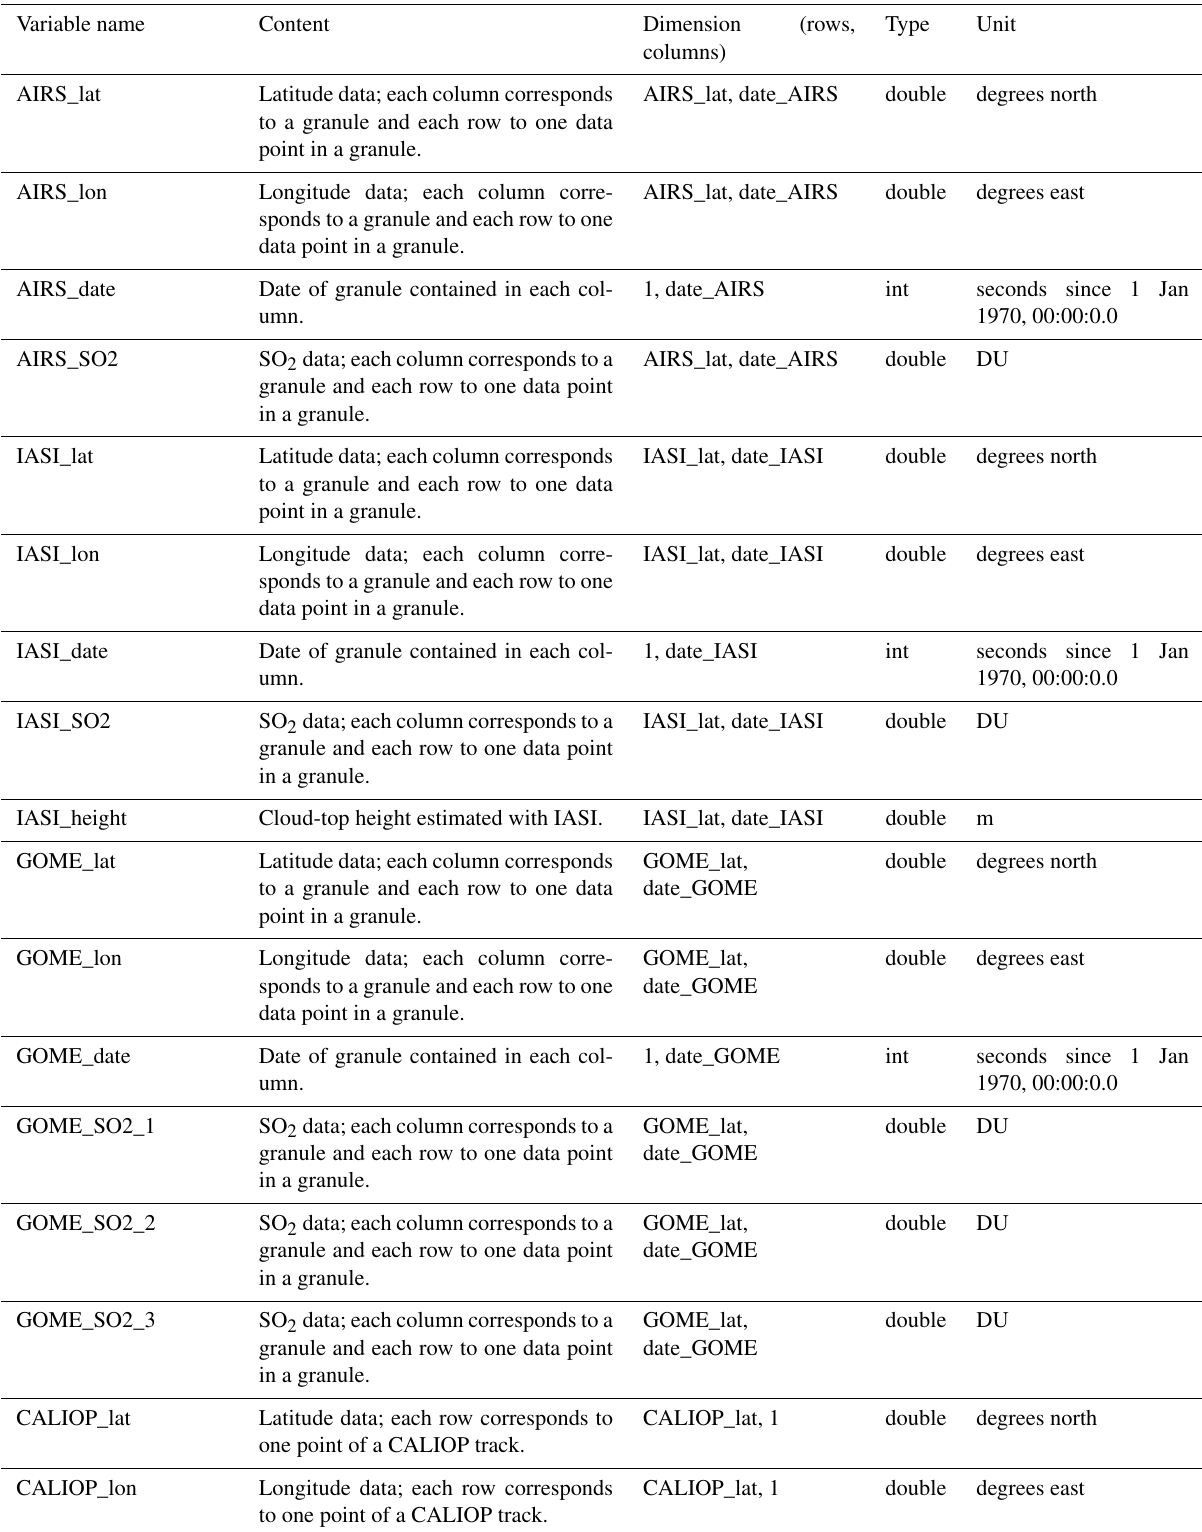
Table 3. General description of all the variables contained in the